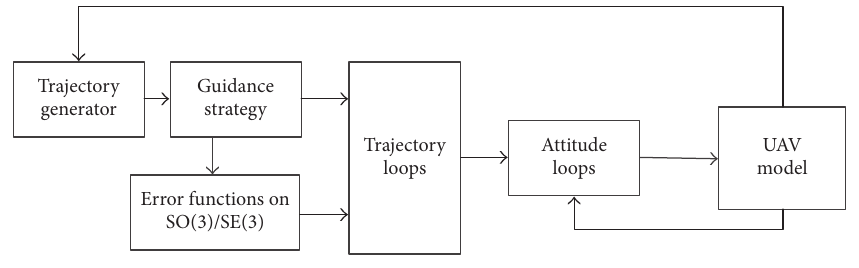
Figure 2: Overview structure of the devised flight control system.